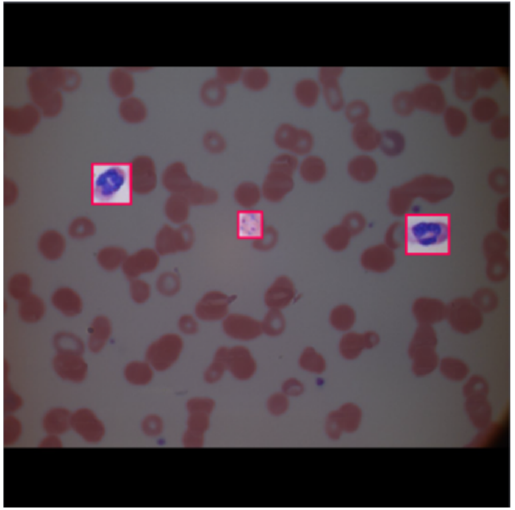
Figure 6. Example of an image after annotation and pre-processing. Roboflow also provides pre-processing and augmentation services. For pre-processing, the data were auto-oriented and then fit to the resolution 1080 × 1080. A consequence of this is the addition of black edges to match the required image resolution. Each image underwent one or more of the augmentations mentioned above, thus increasing the size of the dataset while introducing variability into the dataset. The final dataset before training had a total of 422 images. An example of the augmented data generated after augmentation was performed by Roboflow is depicted in Figure 7.